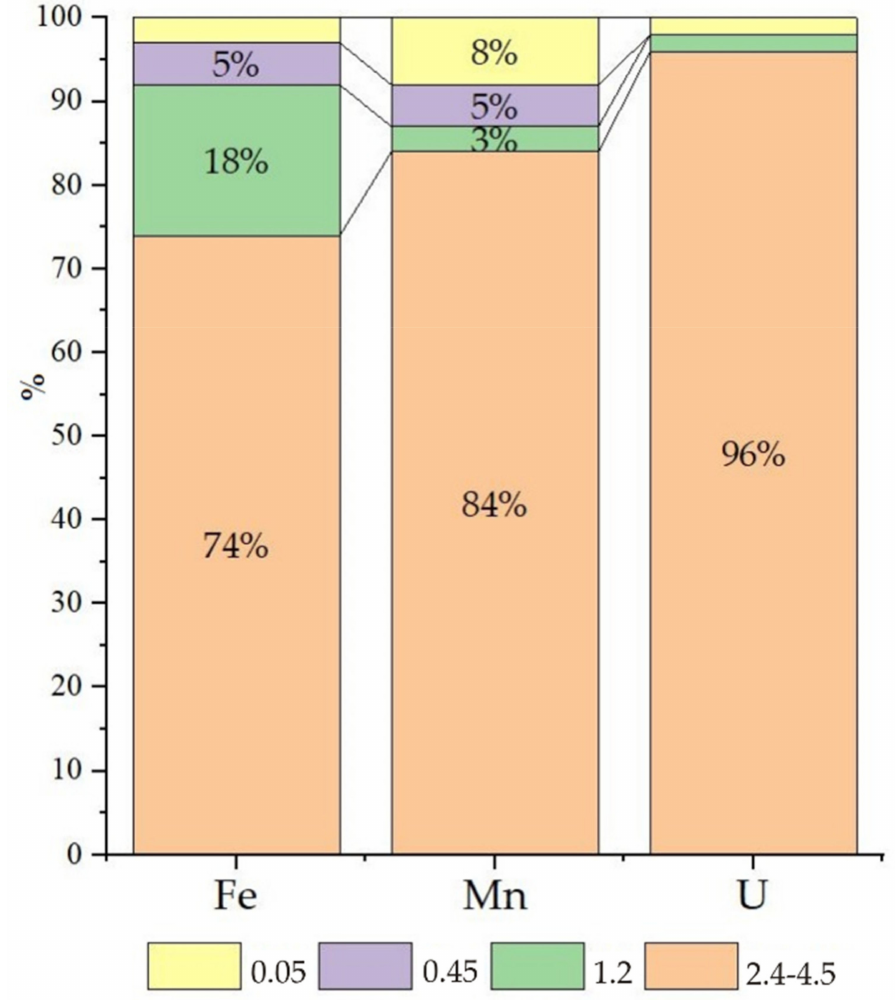
Figure 5. Results of the filtration experiment after the biological process of Sample 3 (compared with Figure